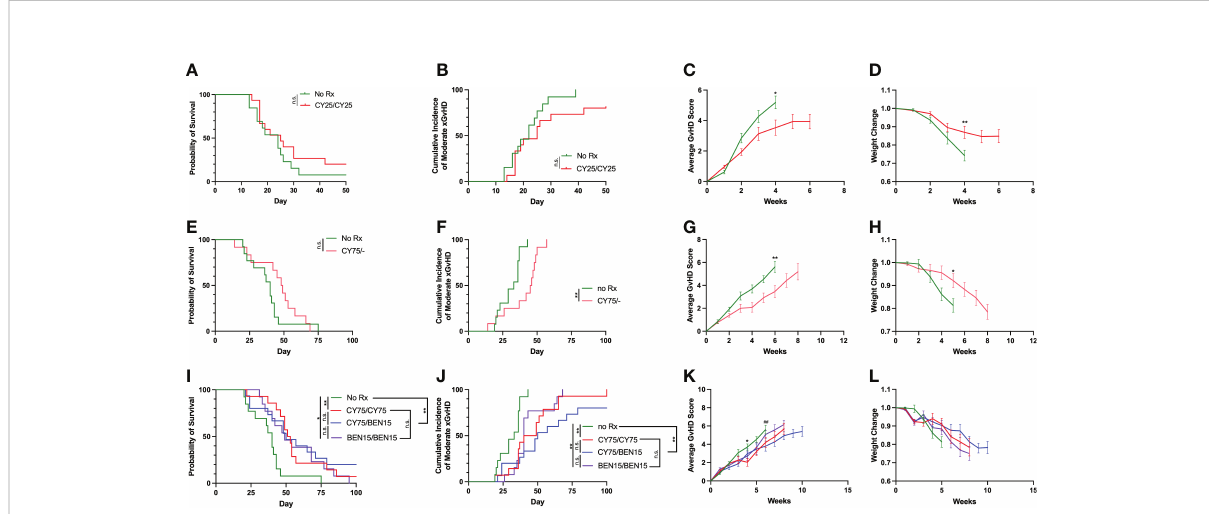
FIGURE 1 CY/CY, BEN/BEN or CY/BEN treatment improves survival and xGvHD severity, whereas lower dose or single day CY treatment is insuf fi cient at improving survival when compared to untreated mice. Animals received 150 cGy irradiation on day -1, were infused with fresh- fi coll separated human PBMCs on day 0 and were treated with (A-D) 25mg/kg of CY on days +3 and +4 (CY25/CY25 n=15), or no pharmacological agent (no Rx n=13), (E-H) 75mg/kg CY on day +3 only (CY75/-, n=12), or no Rx controls (n=13), or (I-L) 75mg/kg of CY on days +3 and +4 (CY75/CY75, n=14), 15 mg/kg BEN on day +3 and +4 (BEN15/BEN15, n=13), 75mg/kg CY on day +3 and 15mg/kg BEN on day +4 (CY75/BEN15, n=15), or no Rx controls (n=13). (A, E, I) Kaplan-Meier survival curves of animals receiving various treatment regimens. (B, C, F, G, J, K) A clinical GvHD scoring system evaluating differences in activity, fur, posture, skin, and weight changes on a scale of 0-2 was used and assessed twice weekly throughout the study, with a possible total score range of 0-10. (B, F, J) Animals receiving a score of 5+ on two consecutive days or death of an animal is marked as an incidence of moderate xGvHD, depicted on graphs. (C, G, K) Average combined xGvHD scores. (D, H, L) Average weight change over time. (A-L) Data are combined from 3 independent experiments using different blood donors for PBMC infusion, with 12-15 total mice per group. (A, B, E, F, I, J) The Log-rank Mantel-Cox test for survival/incidence curves was used for statistical analysis, with p values indicated by the number of asterisks between groups: *<0.05, **<0.01, n.s.= not signi fi cant. (C, D, G, H, K, L) Statistics were run using a two- way ANOVA followed by S ̌ ı ́ da ́ k ’ s multiple comparisons. P values are indicated by number of symbols between groups noted on graphs * missing0.05, **<0.01. (K, L) Asterisks (*) indicate differences between no Rx and CY75/CY75. Pound symbols (#) indicate differences between no Rx and